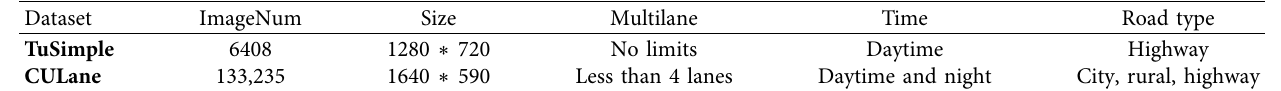
Figure 7: Some pictures in CULane dataset. (a) No line and crowded. (b) Dazzle light. (c) Night. (d) Arrow. Table 2: Basic information about TuSimple dataset and CULane dataset.